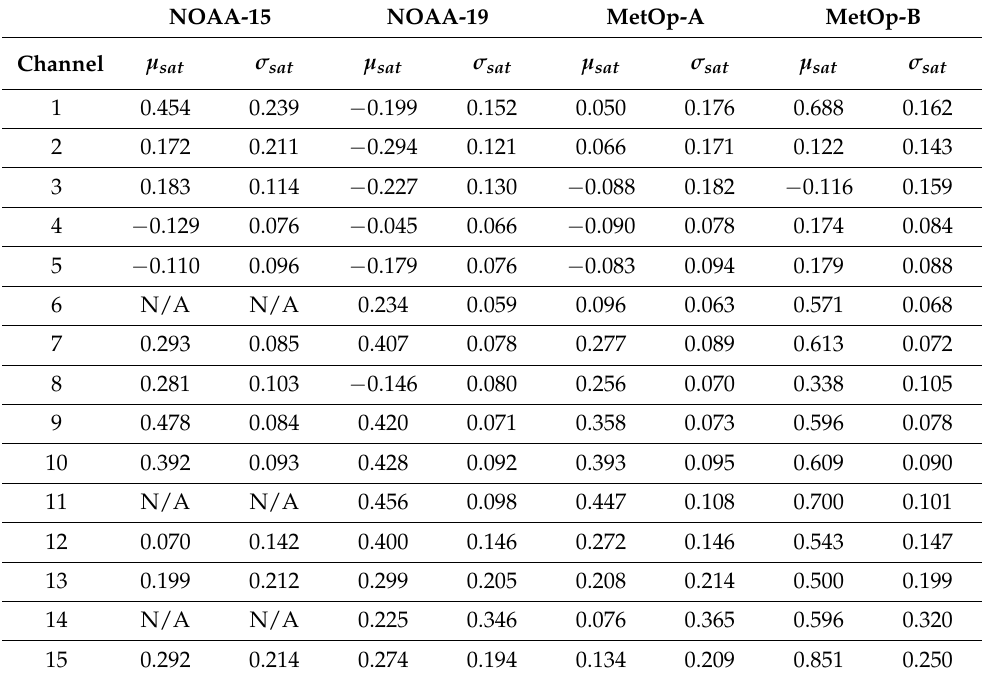
Table 3. Inter-sensor biases ( µ sat , unit: K) for AMSU-A channels between NOAA-15, -19, MetOp-A, -B, and NOAA-18. σ sat (unit: K) is the standard deviation. N/A stands for “not available.”